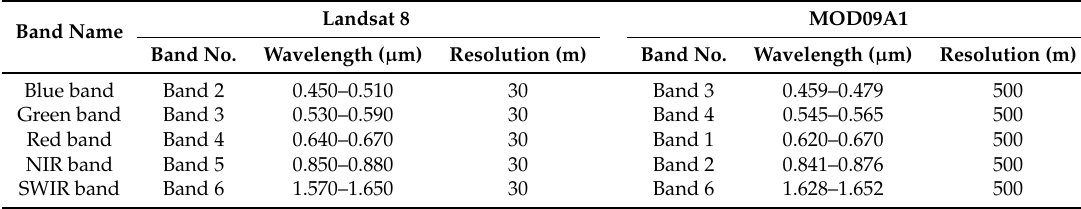
Figure 2. Scene acquisition dates by year for the Landsat, MODIS, and enhanced spatial and temporal adaptive reflectance fusion model (ESTARFM)-predicted images. Table 2. Brief characteristics of LANDSAT 8- and MODIS-selected